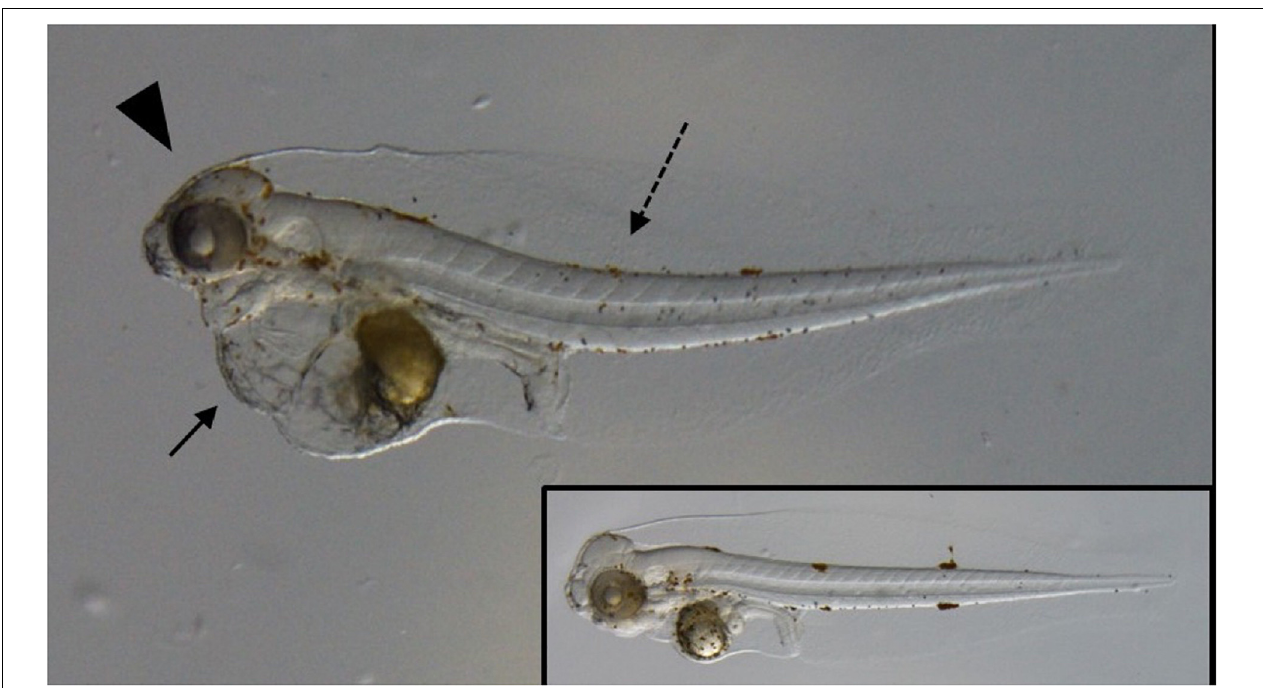
FIGURE 7 | Representative image of a larval red drum displaying the typical effects of oil exposure on early life stage fishes. The image demonstrates the pericardial and yolk sac edema (arrow), spinal curvature (dashed arrow) and craniofacial malformations (arrowhead) that coincided with a 48 h exposure to 2.6 µ g/L (cid:54) PAH 50 via a weathered oil water accommodated fraction. Insert shows control fish from the same experiment. Images courtesy of Khursigara et al. (2017).